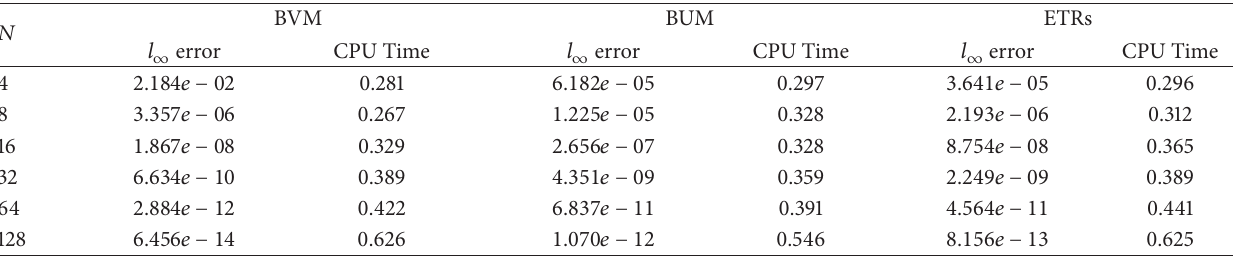
Table 1: Computational results for V = 2 for Example 5.1.